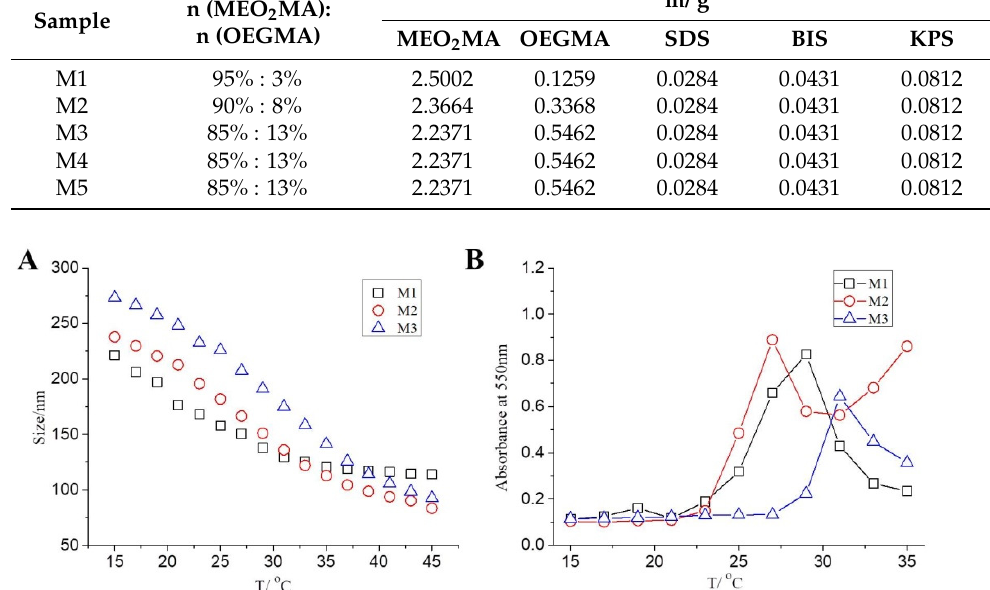
Figure 1. Hydrodynamic radius ( A ) and absorbance ( B ) of P(OEGMA-co-MEO 2 MA) microgel samples M1-M3 as a function of temperature. Table 1. The feeding amount of each sample during the preparation process.